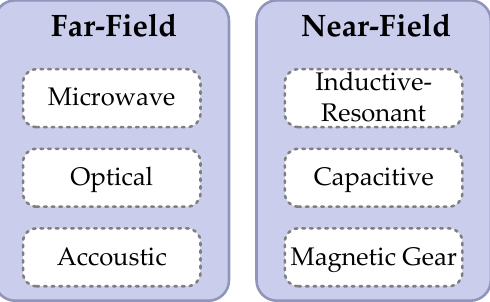
Figure 3 . Categorization of WPT technologies. Figure 3. Categorization of WPT